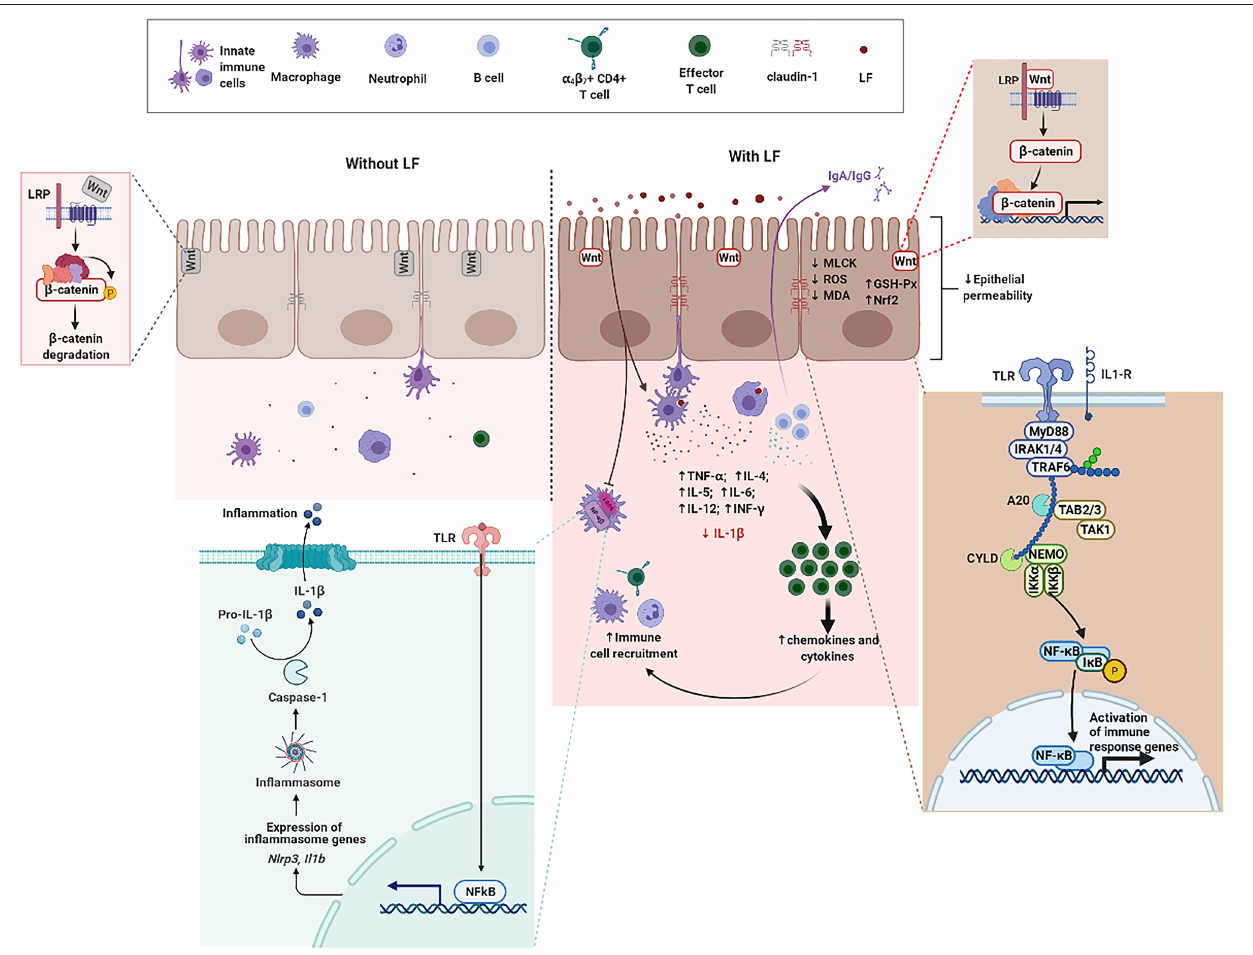
FIGURE 2 | The functional role of LF on intestine mucosal immune system in the context of IBD. Without LF (Left) , the intestine mucosal immune system follows the path of autoimmune regulation. The presence of LF (Right) promotes TJ between epithelial cells, enhances the expression of β -catenin, and activates the Wnt signaling pathway. LF downregulates the protein abundance of MLCK, reduces the level of ROS and MDA, enhances GSH-Px activity, and upregulates the expression level of Nrf2 in epithelial cells. LF enhances the expression level of TLRs and activates the NF- κ B pathway. LF also reduces the secretion and the gene expression of IL-1 β , enhances the function of immune cells, promotes the production of cytokines, and promotes the recruitment of immune cells. GSH-Px, glutathione peroxidase; IL-1 β , interleukin-1 β ; LF, lactoferrin; NF- κ B, nuclear factor kappa-B; Nrf2, nuclear factor erythroid 2-related factor 2; MDA, malondialdehyde; MLCK, myosin light chain kinase; ROS, reactive oxygen species; TJ, tight junction; TLRs, toll-like